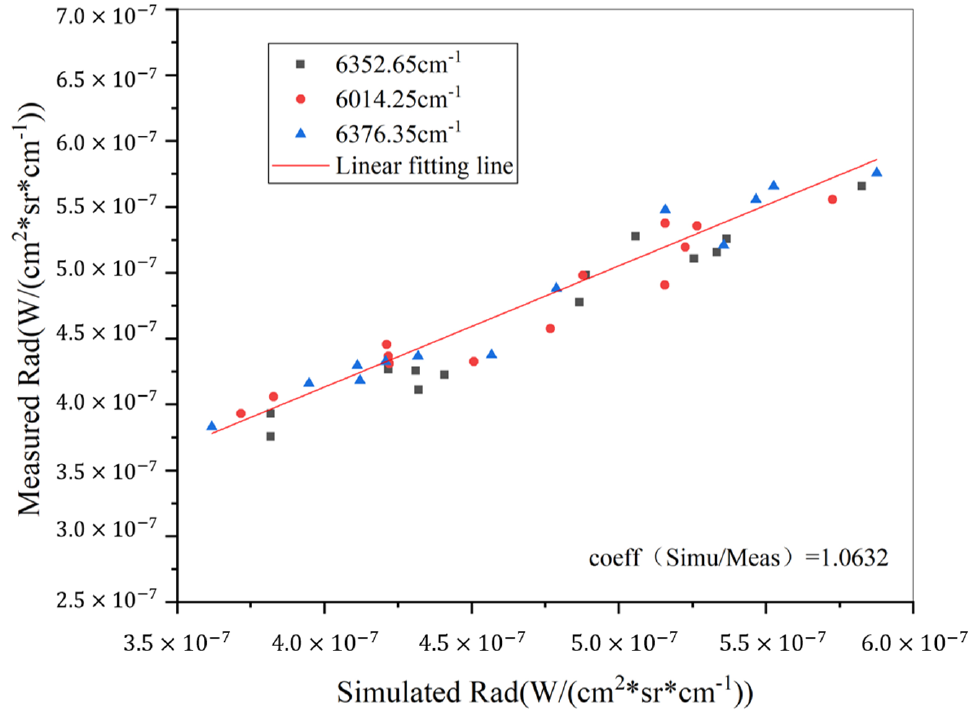
Figure 19. Calculation of site calibration coefficient of the CO 2 -1 channel at the Kufra, Libya site. According to the calculation method of the GMI site calibration coefficient combined with the GMI data matching results in Section 3, the effective observation data within the time range from September to December 2018 are obtained, and the time series site calibration results of different channels of GMI are statistically analyzed to monitor the attenuation changes in each channel during the in-orbit operation of the load. For a channel with a large attenuation, the calibration coefficient should be corrected to improve the product accuracy of the observed spectral data and ensure data stability during the long- term in-orbit operation of the load. The calculation results of the calibration coefficients of each spectral channel are shown in Figure